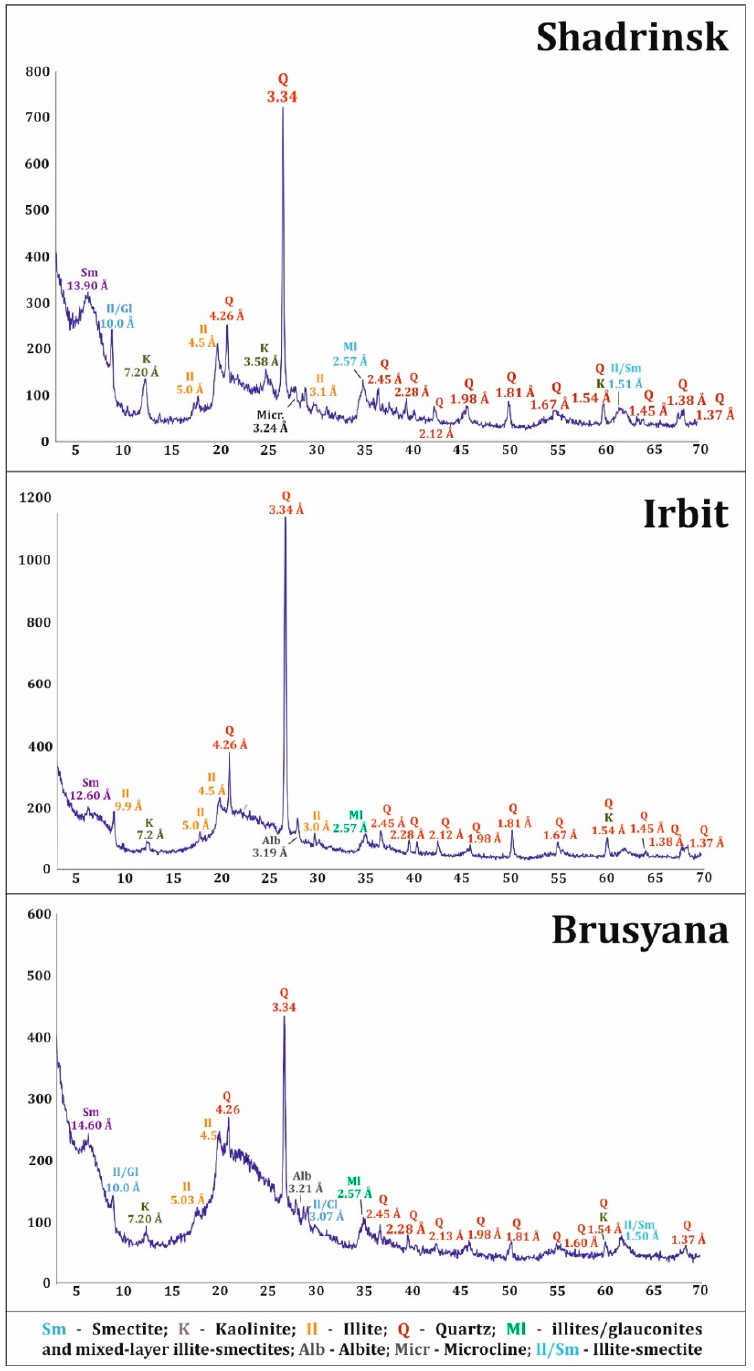
Figure 2. Representative X-ray diffraction (XRD) patterns of powder of air-dried samples. Table 1. Results of grain size analysis.